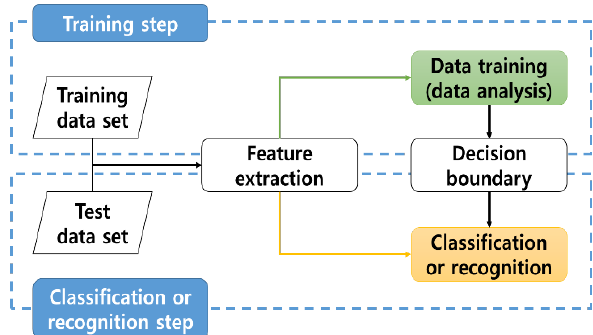
Figure 1. A general processing in machine learning